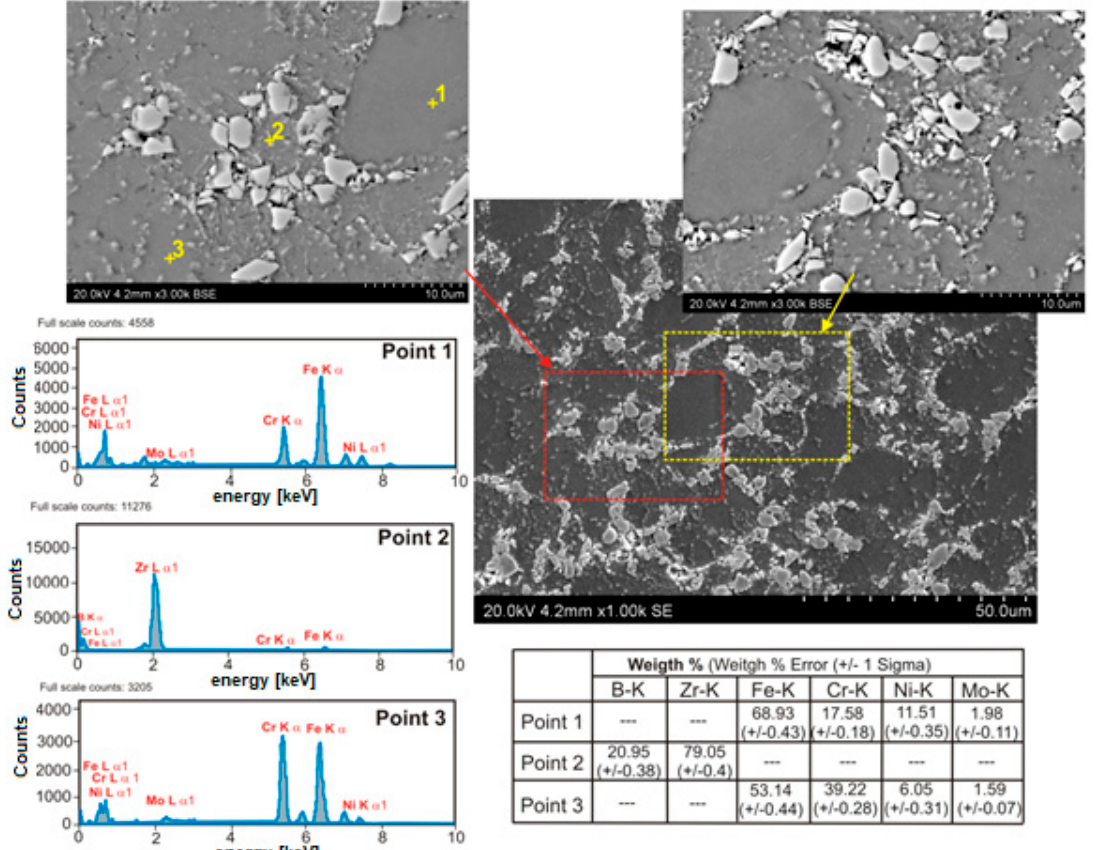
Figure 5. The microstructure (SEM) of steel +20% ZrB 2 with corresponding area analysis